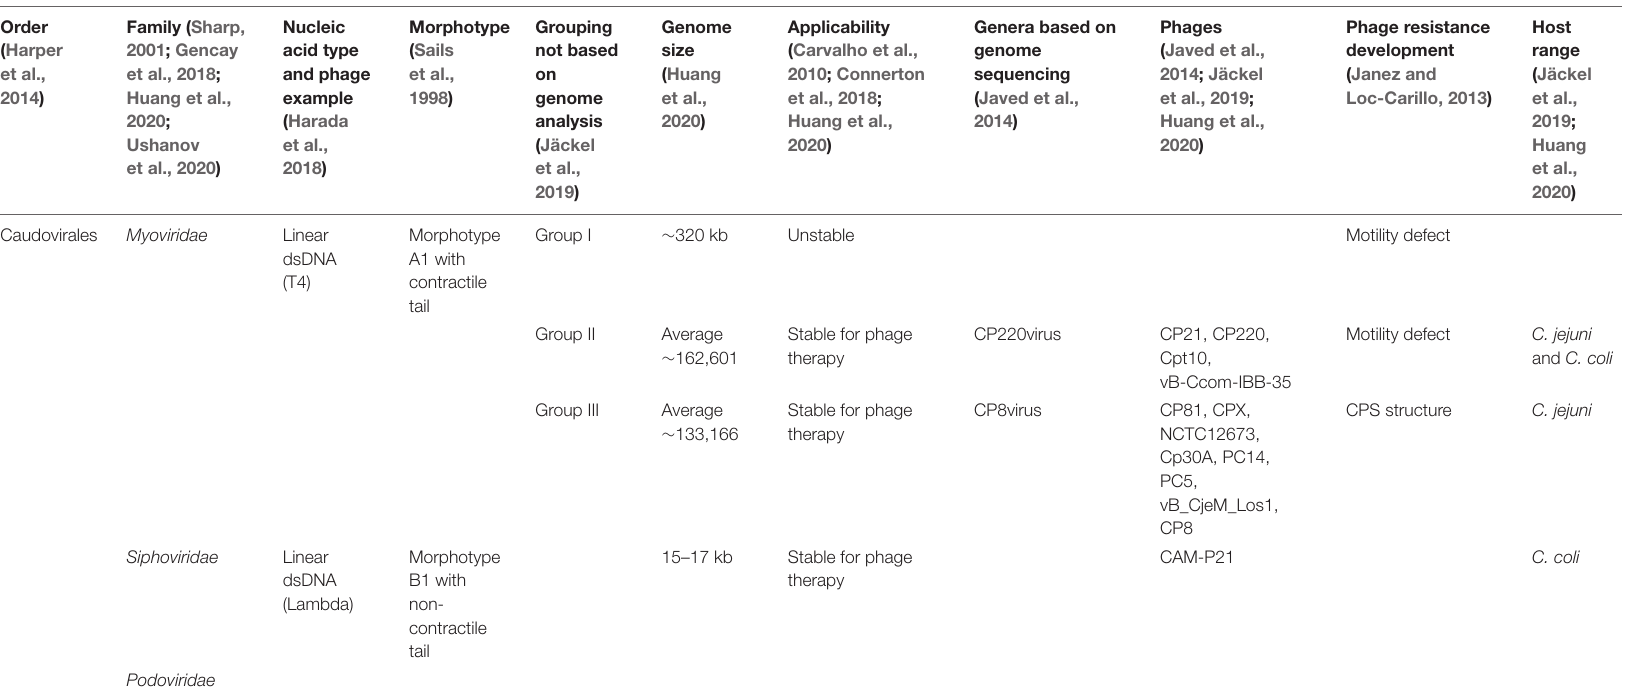
TABLE 1 | Campylobacter phages taxonomy and description. Order